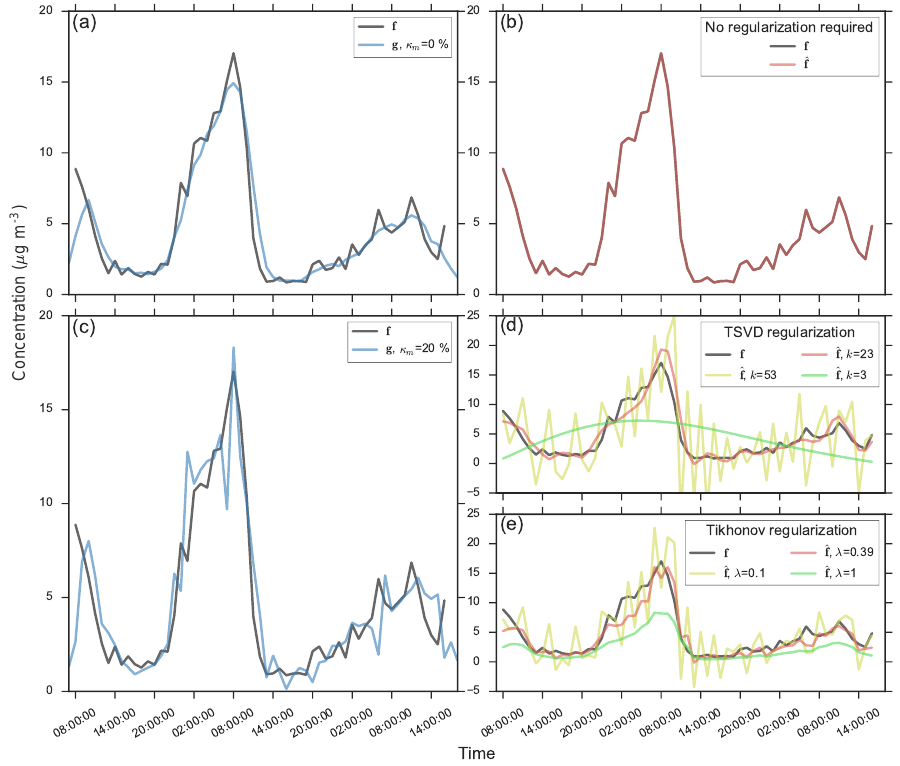
Figure 5. Explanation of different types of time series: f is an original time series of HOA concentrations; g are smeared time series produced from the staggering of 4h samples ( (cid:49)τ = 4h) at 1h intervals ( δτ = 1h) (a) without ( κ m = 0%) and (c) with the addition of normally distributed random measurement error ( κ m = 20%). The right panels contain time series ˆ f recovered by deconvolution of the smeared time series g in the corresponding left panels. When κ m = 0% (b) , the true time series can be completely recovered by deconvolution. No regularization is required. When κ m = 20%, (d) TSVD regularization with appropriate choice of k( = 23 ) , or (e) Tikhonov regularization with appropriate choice of λ( = 0 . 39 ) are required to obtain solutions that approximate the true time series well. Table 1. Modeling